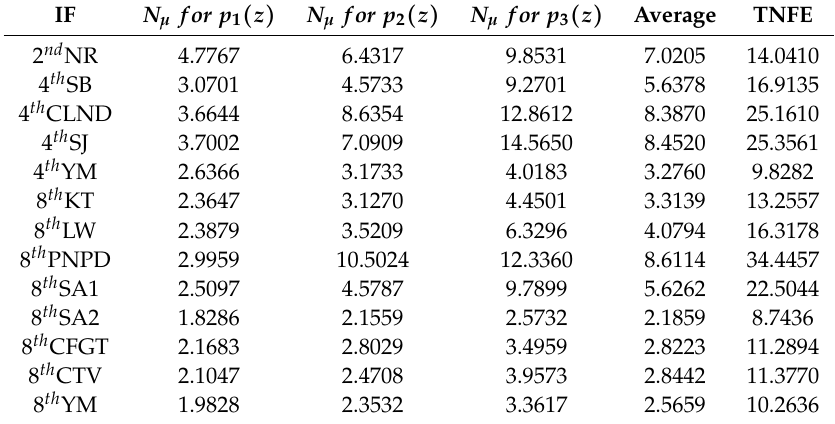
Table 11. Mean number of iteration ( N µ ) and TNFE for each polynomials and each methods. IF N µ for p 1 ( z ) N µ for p 2 ( z ) N µ for p 3 ( z ) Average